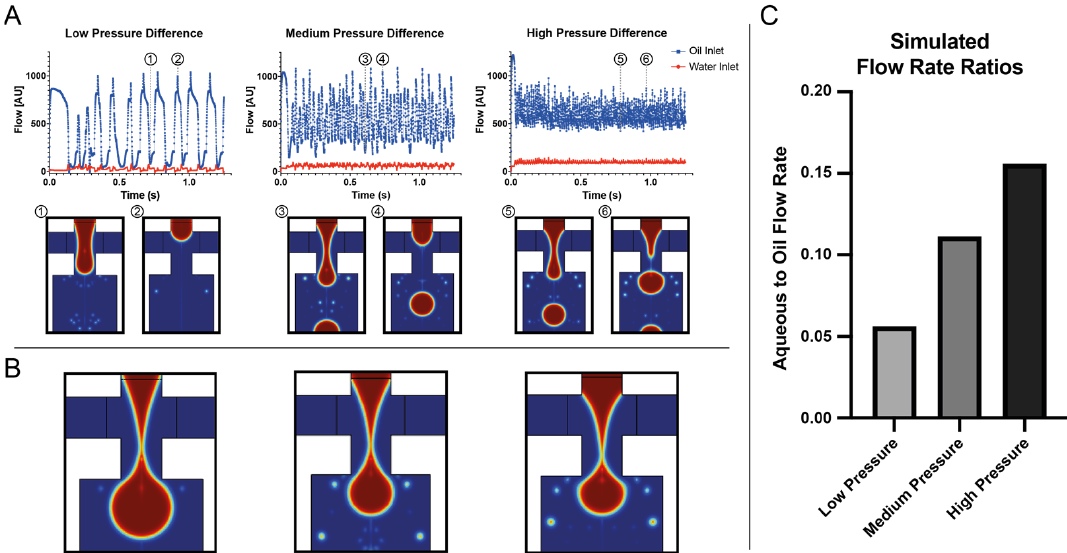
Figure 3. Simulation of microfluidic droplet generation behavior with different applied negative pressures at the outlet. ( A ) shows flows through the respective inlets. The respective flows are oscillating through the droplet break-off, indicating an increase in droplet rate the higher the applied pressure differential. Images (1) and (3) and (5) depict a snapshot of the nozzle at minimal oil flow, (2) and (4) and (6) show the nozzle at maximal oil flow. ( B ) shows the respective droplets immediately prior to break-off. ( C ) shows the dispersed aqueous phase flow normalized to the continuous oil phase flow for the three simulated pressure differentials, indicating an increase in the aqueous-to-oil ratio for increasing negative pressures.